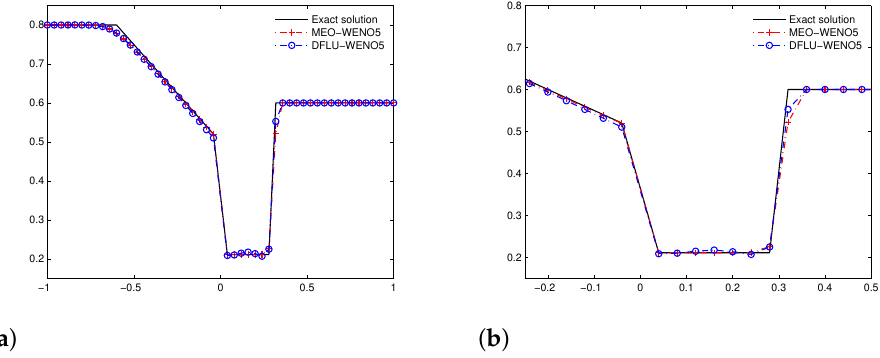
Figure 4. Example 1 computed by the MEO-WENO5 and DFLU-WENO5 with ∆ x = 1/25. ( a ): the numerical and exact solutions; ( b ): the numerical and exact solutions zoomed in.